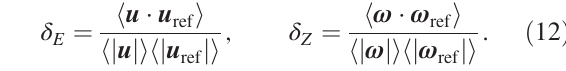
, (middle) filtered or nudging fields I u ref